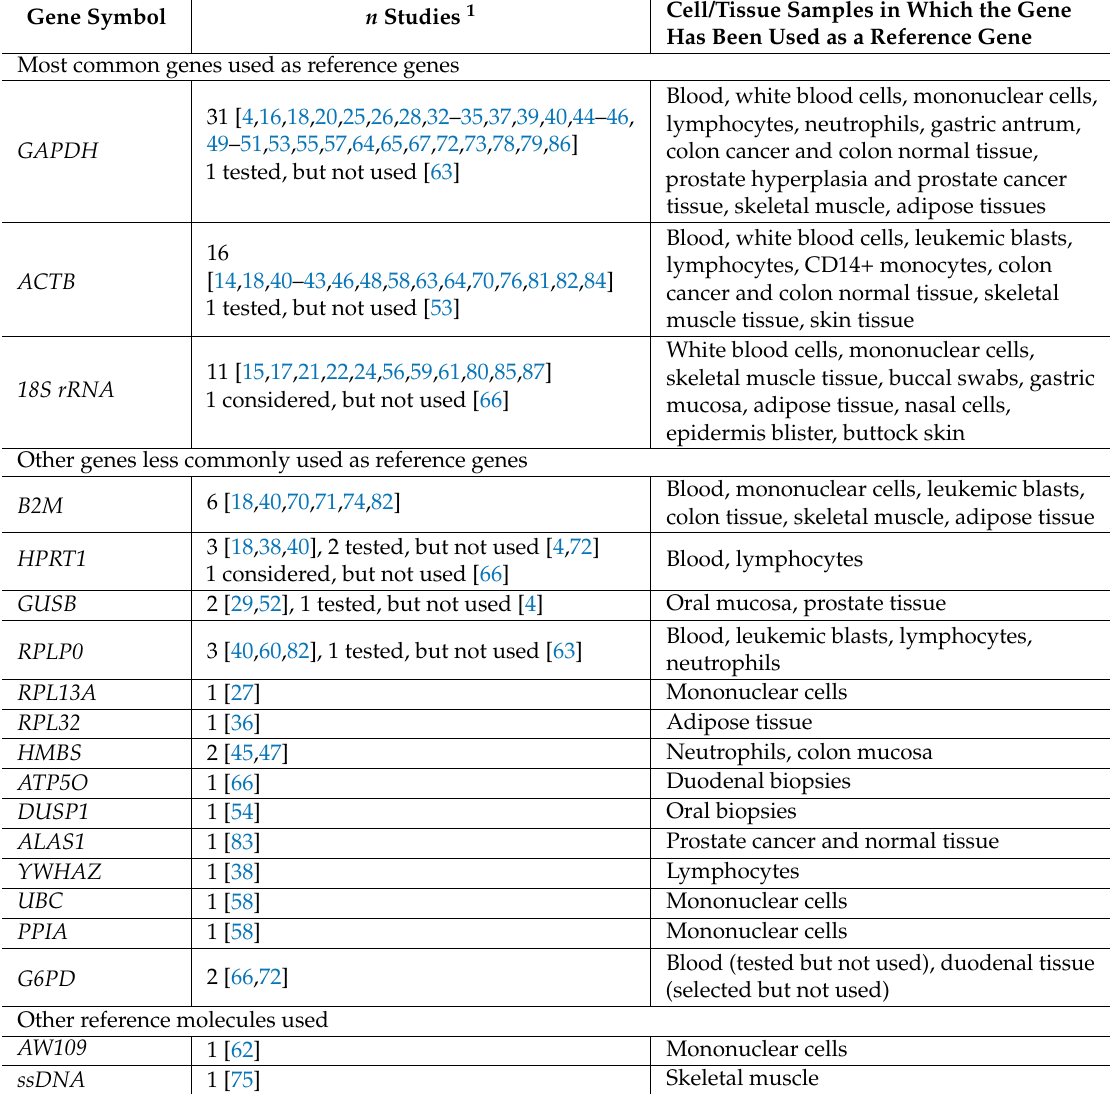
Table 1. List of reference genes reported in the human intervention studies included in this